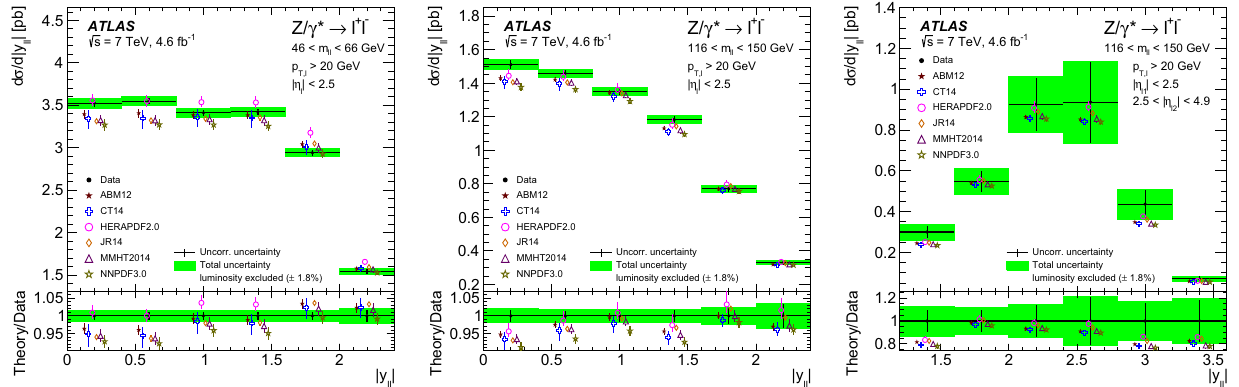
Fig. 24 Differential cross-section measurement d σ/ d | y (cid:3)(cid:3) | for Z /γ ∗ → (cid:3)(cid:3) in the central-rapidity low-mass region ( left ), the central-rapidity high-mass region ( middle ), and the forward-rapidity high-mass region ( right ). Predictions computed at NNLO QCD with NLO EW corrections using various PDF sets ( open symbols ) are